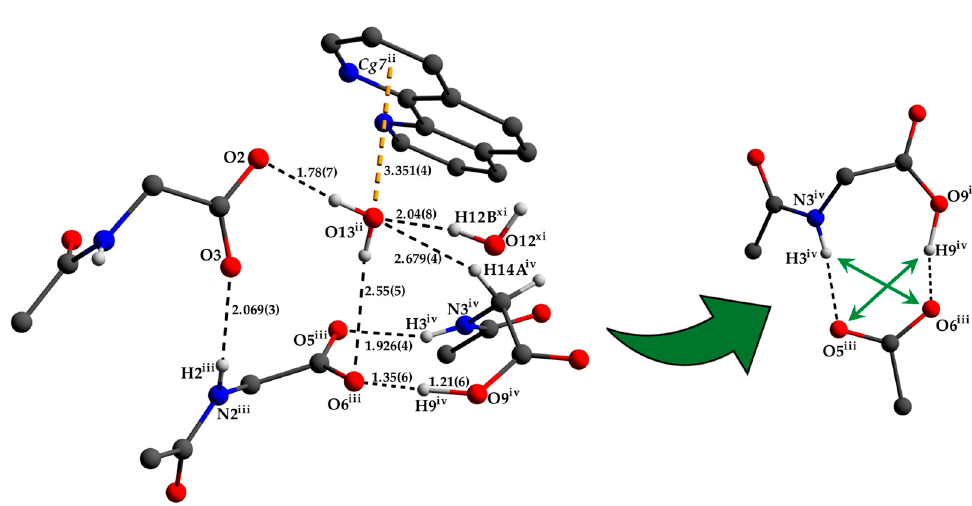
Figure 3. Detailed view of the anion connection via hydrogen bonding and the environment of the O13 water molecule with lone-pair ··· π interaction (left) as well as the attractive secondary electrostatic interactions (right). The hydrogen atoms which are not involved in hydrogen bonding have been omitted for clarity. Bond lengths are given in Å. Symmetry codes: (ii) − x + 1/2, y + 1/2, z; (iii) − x, − y + 1, − z + 1; (iv) x − 1/2, − y + 3/2, − z + 1; (xi) − x + 1, y, z (see Tables S1–S3 for